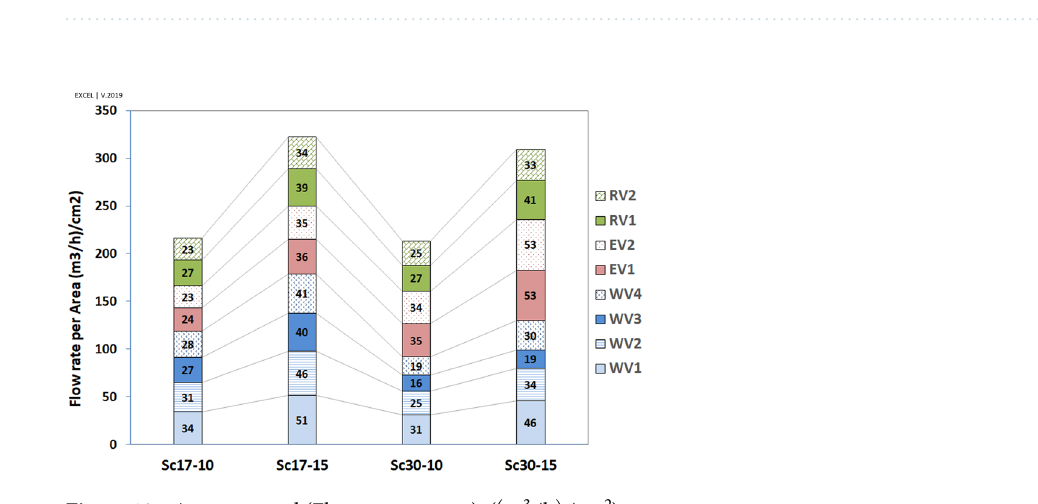
Figure 19. Average speed (Flow rate per area),